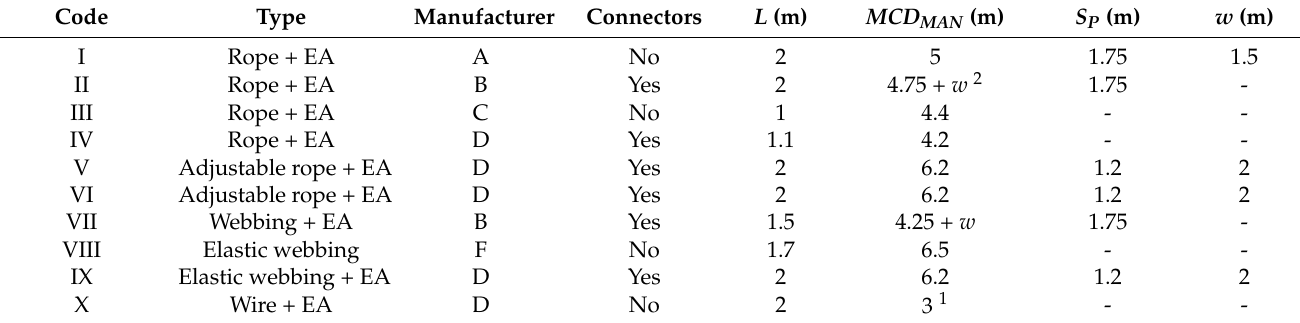
Table 2. Samples technical specifications according to the manufacturer’s instruction